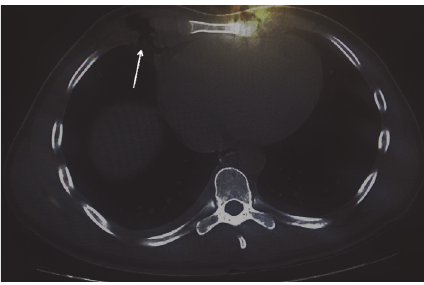
Figure 2: Axial contrast-enhanced CT of the chest. Note the disruption in the thoracic cavity with lung anterior herniation due to fractured ribs (arrow).